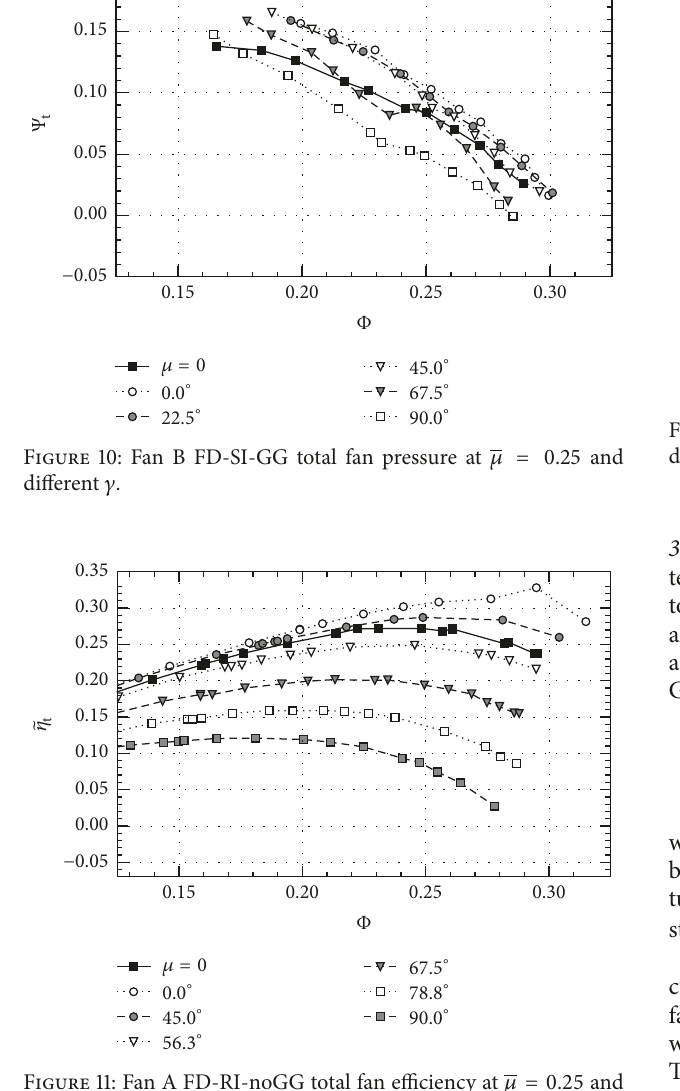
Figure 11: Fan A FD-RI-noGG total fan efficiency at 𝜇 = 0.25 and different 𝛾 .